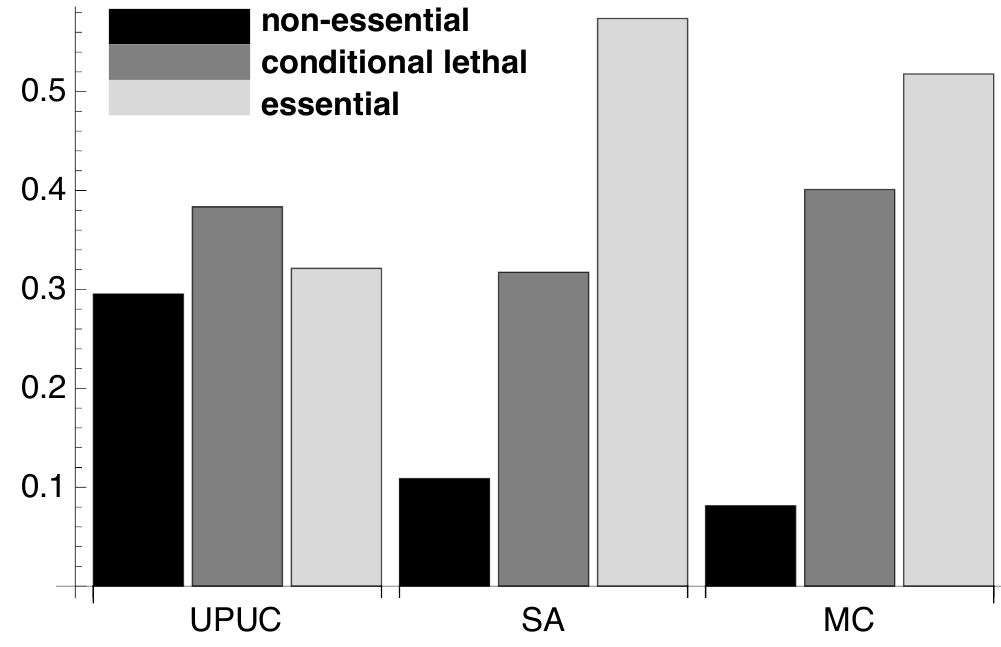
Figure 4. Reaction categories and essentiality classes. The proportions of the three different essentiality classes determined for UPUC, SA and MC component (for absolute numbers see Supplementary Figure